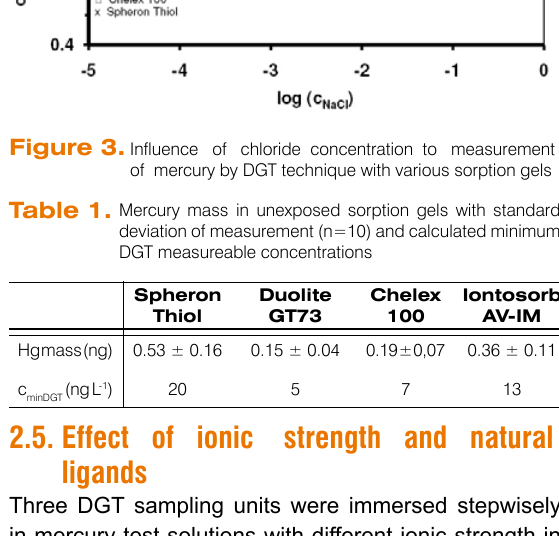
Chelex Iontosorb 100 AV-IM